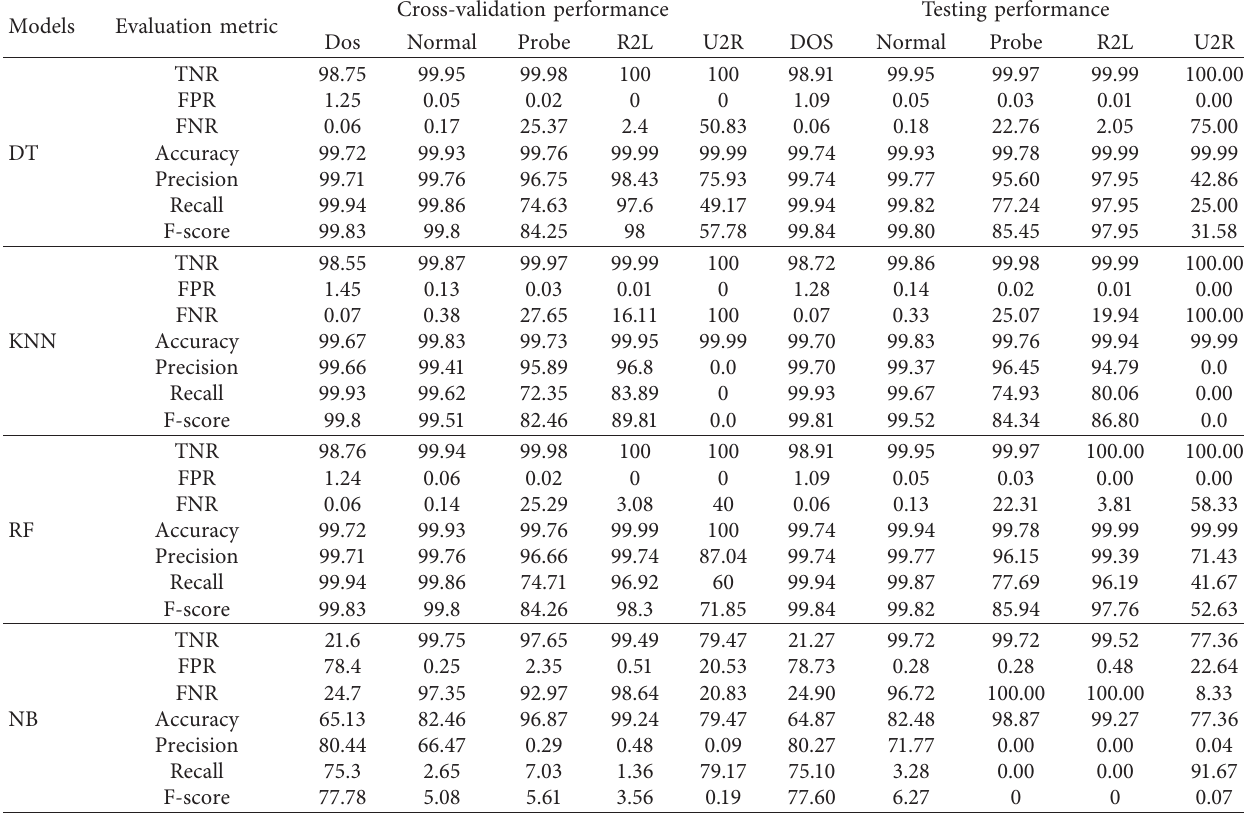
Table 15: The performance of machine learning for KDD dataset using selected features. Models Evaluation